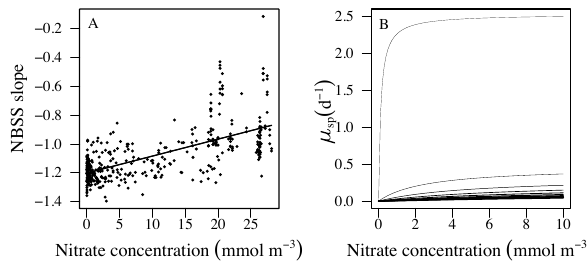
Figure 2. Functional forms of (a) normalized biomass spectrum (NBSS) and (b) phytoplankton species growth rate to nutrient con- centration. (b) Simple allometric equations are indicated by the size range from small (thinnest lines) to large (thickest lines) size species. (a) The solid line represents the linear regression.